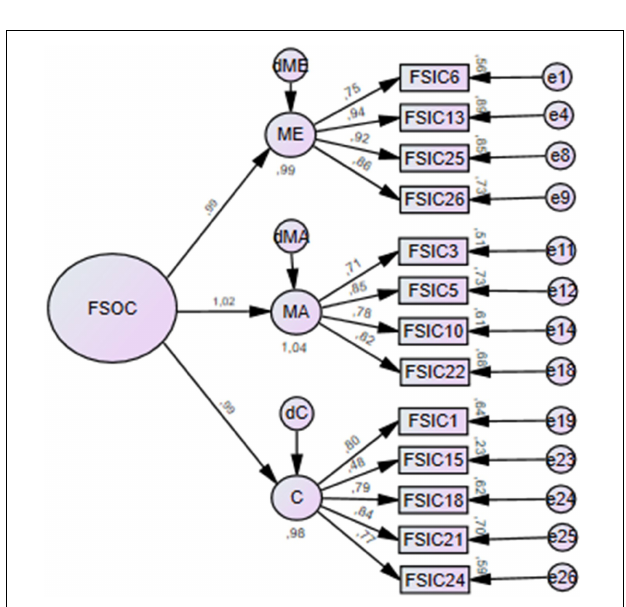
FIGURE 2 | Second-order factor structure model for confirmatory factor analysis.